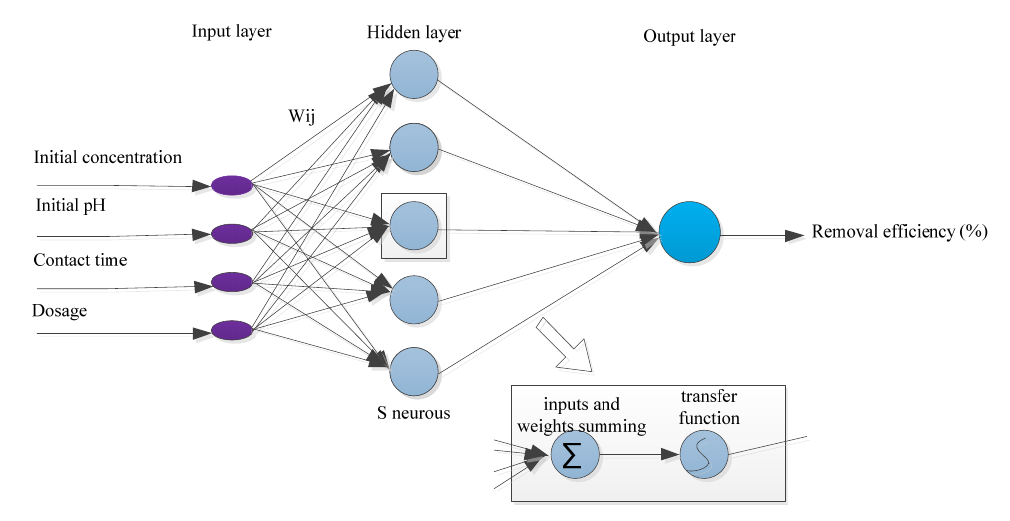
Figure 3. Back propagation artificial neural network (BP-ANN) structure.